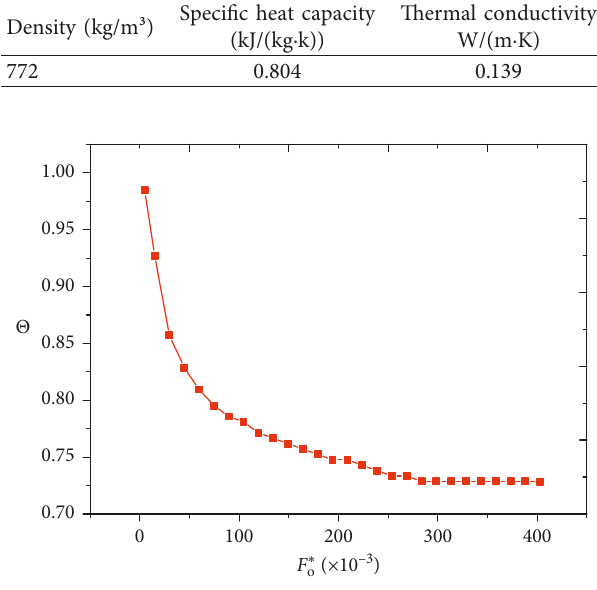
Figure 5: Effect of F